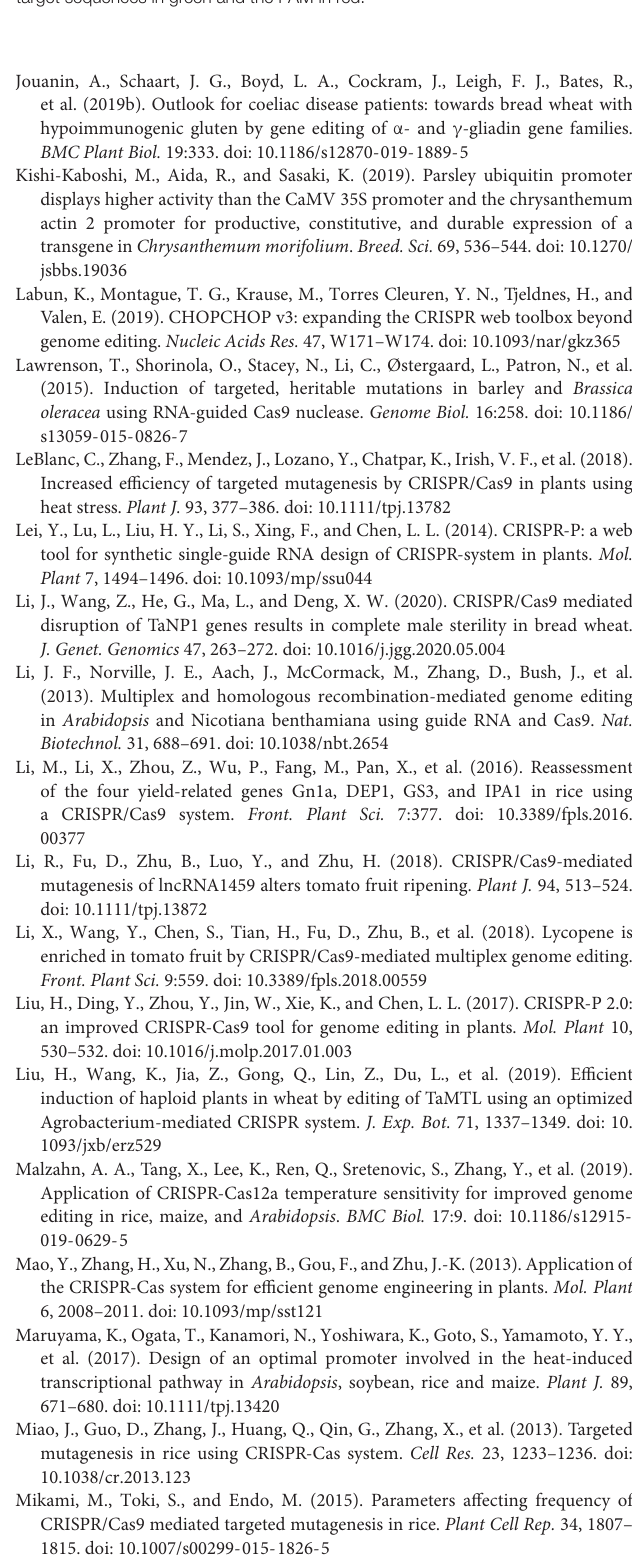
Supplementary File 1 | Upstream region of TraesCS7A02G014100. Binding sites for primers MM542 (forward) and MM541 (reverse) are highlighted in blue, guide target sequences in green and the PAM in red. target sequences in green and the PAM in